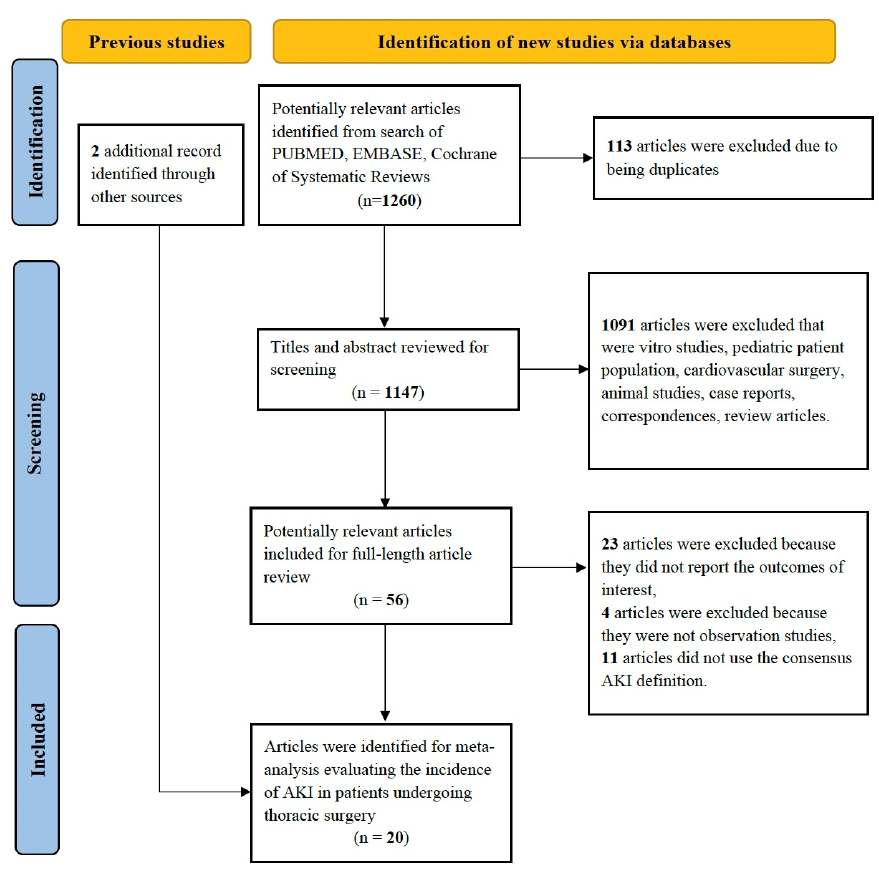
Figure 1. Study identification and selection procedure.